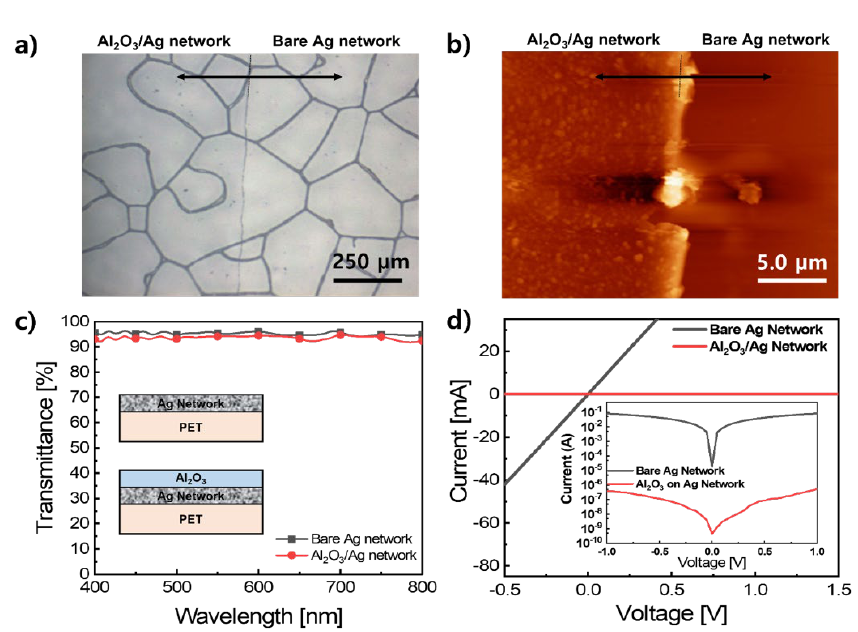
Figure 2. ( a ) Optical microscopy and ( b ) surface AFM images of the boundary between the Al 2 O 3 - covered and uncovered regions on the Ag network template. ( c ) Optical transmittance and ( d ) I-V curves of the bare Ag network template and Ag network with the Al 2 O 3 passivation layer.